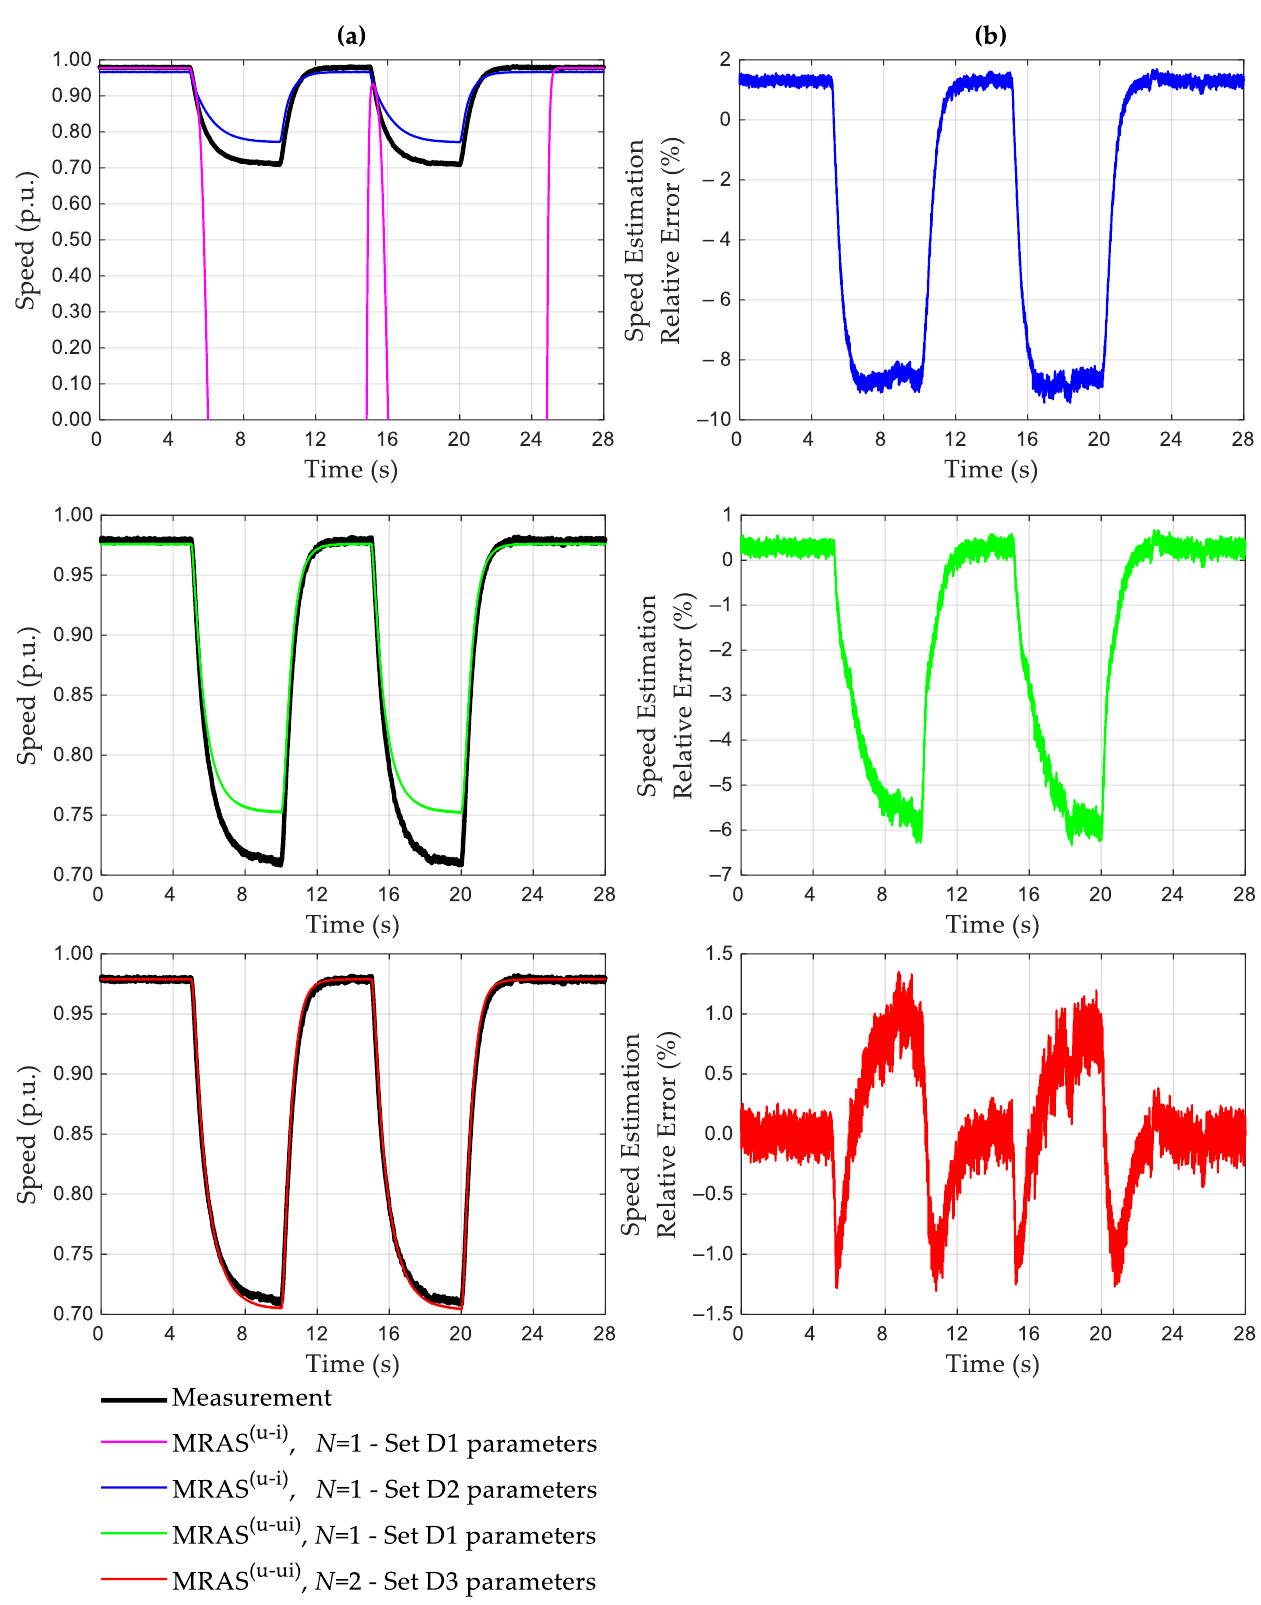
Figure 7. The speed estimation of the tested SR IM: ( a ) the measured and estimated speeds; ( b ) the speed estimation relative errors.